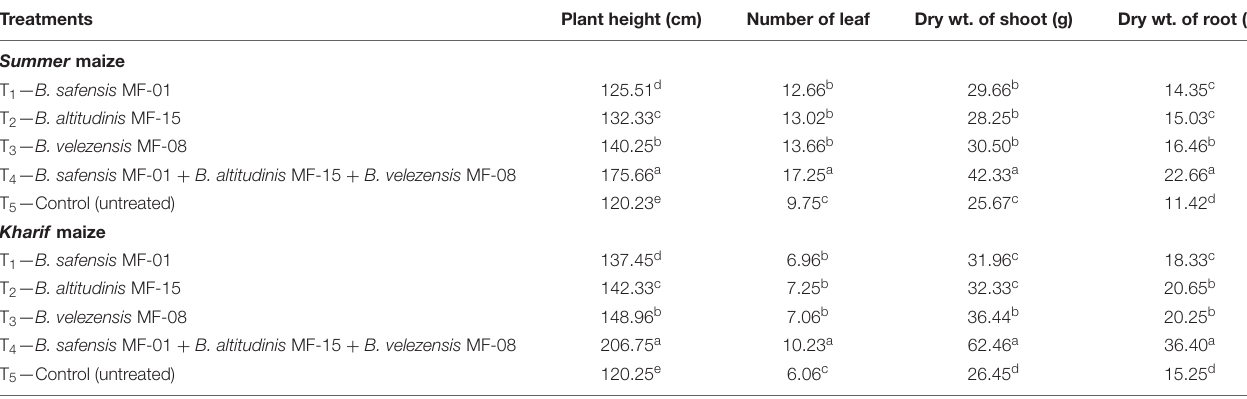
TABLE 6 | Effects of seed biopriming and microbial intervention on plant growth parameters in maize grown in Summer and Kharif season under field conditions at 45 days of sowing. Treatments Summer maize